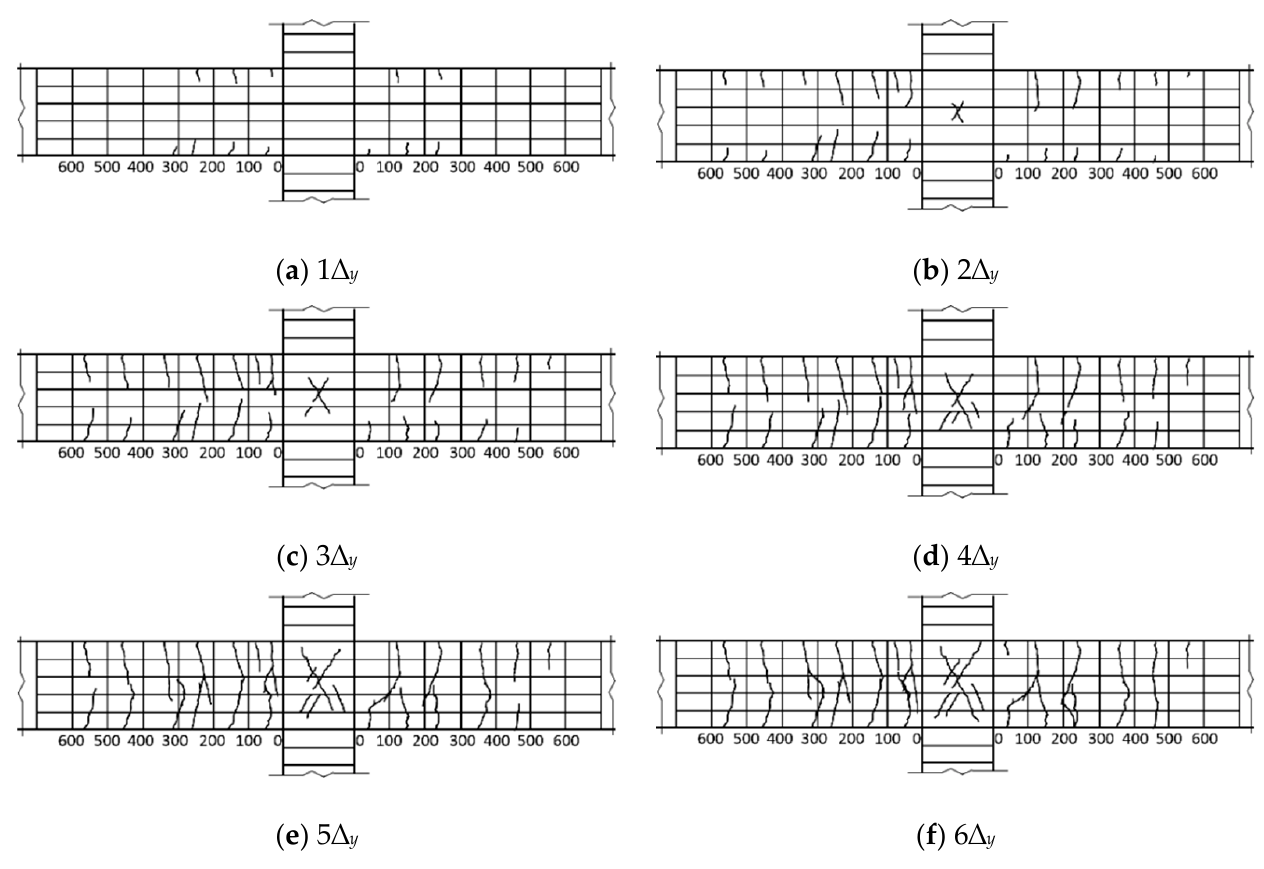
Figure 7. Crack development of specimen BCJ1.